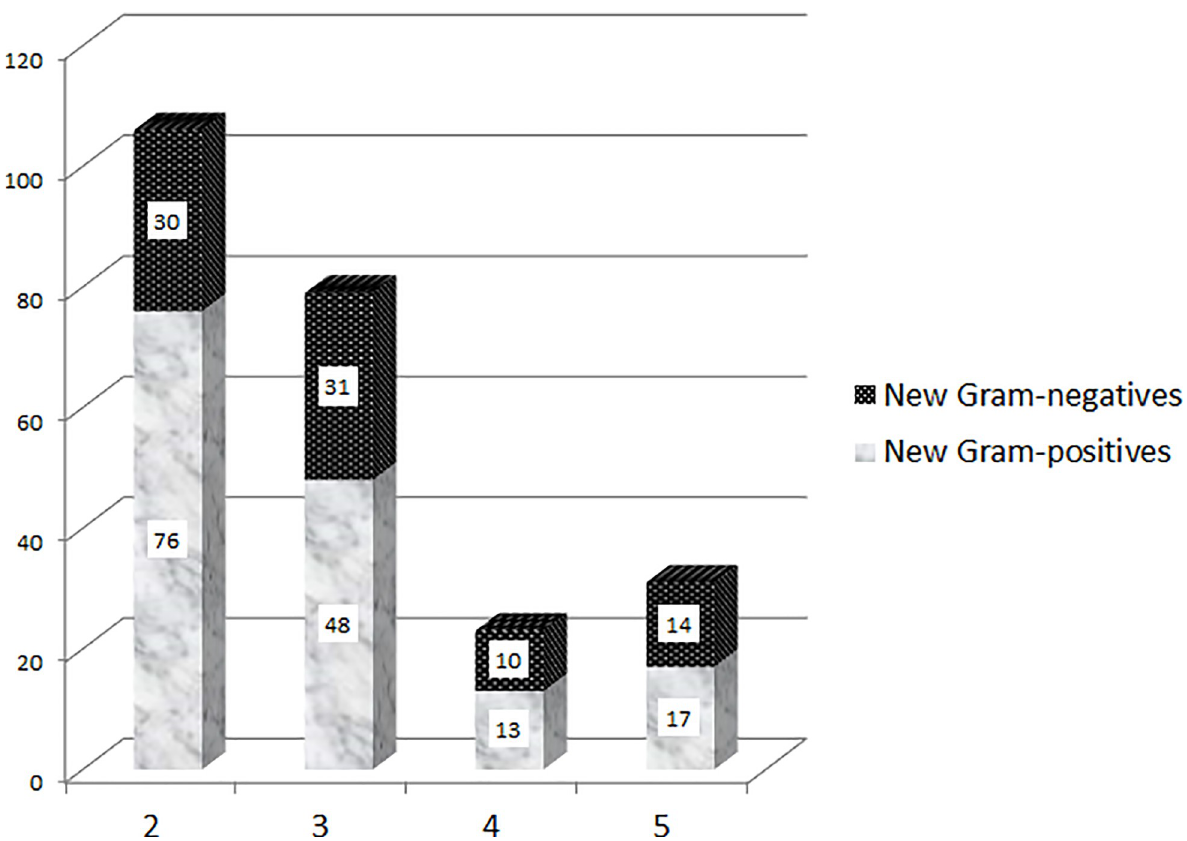
Fig 2. Total number of new pathogens (vertical axis) stratified upon the Gram coloration and the number of debridement (horizontal axis).